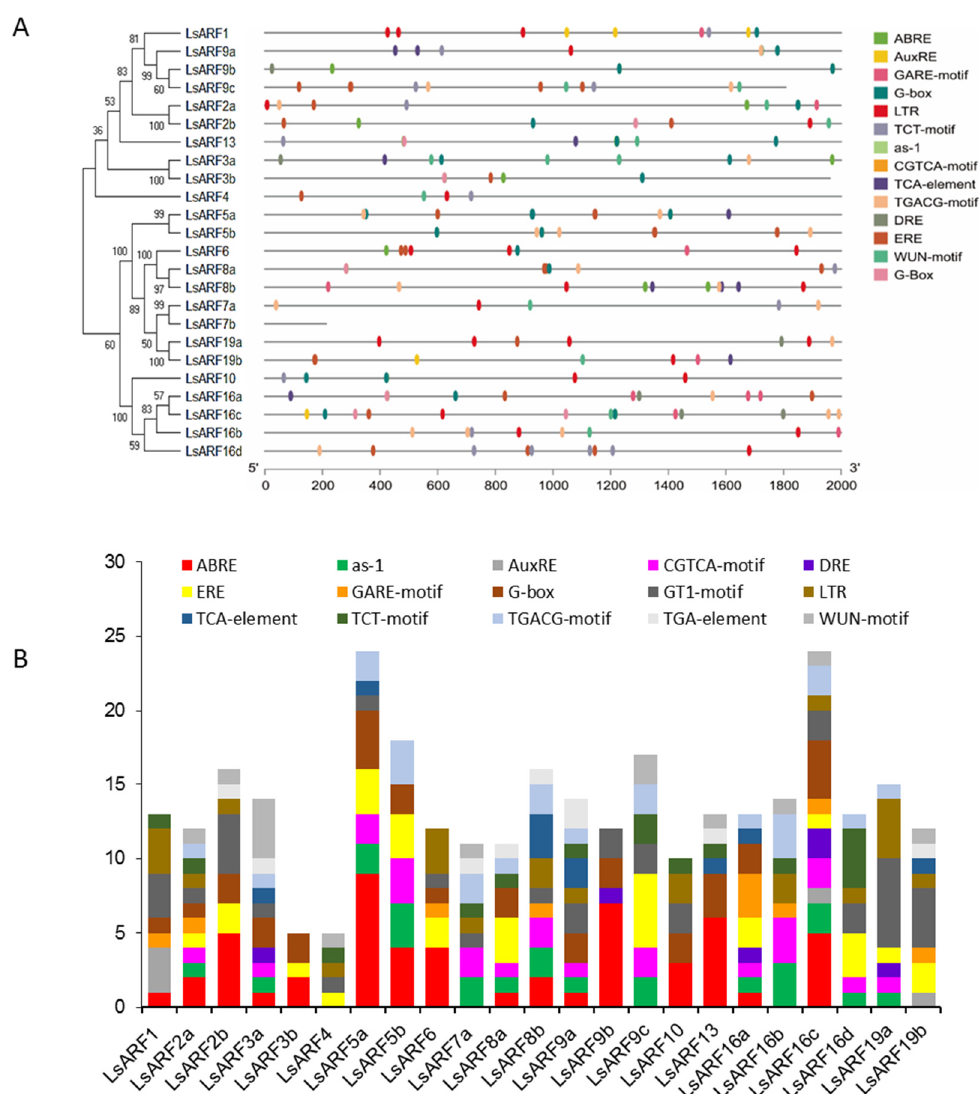
Figure 4. Identification of the cis-acting elements in the putative promoter region of LsARF genes. ( A ) The distribution of 15 major cis-elements in the putative promoter of LsARF genes. Fifteen cis-elements including auxin-responsive elements (AuxRE), as-1, ABA-responsive element (ABRE), CGTGCA motif, dehydration-responsive element (DRE), ethylene-responsive element (ERE), gibberellin-responsive motif (GARE), G-box, GT1-motif, low-temperature-responsive element (LRE), TCA-element, TCT-motif, TGACG motif, TGA element, and wound-responsive element (WUN) are designated with different colors. ( B ) Number of different cis-elements in the LsARF promoter regions.